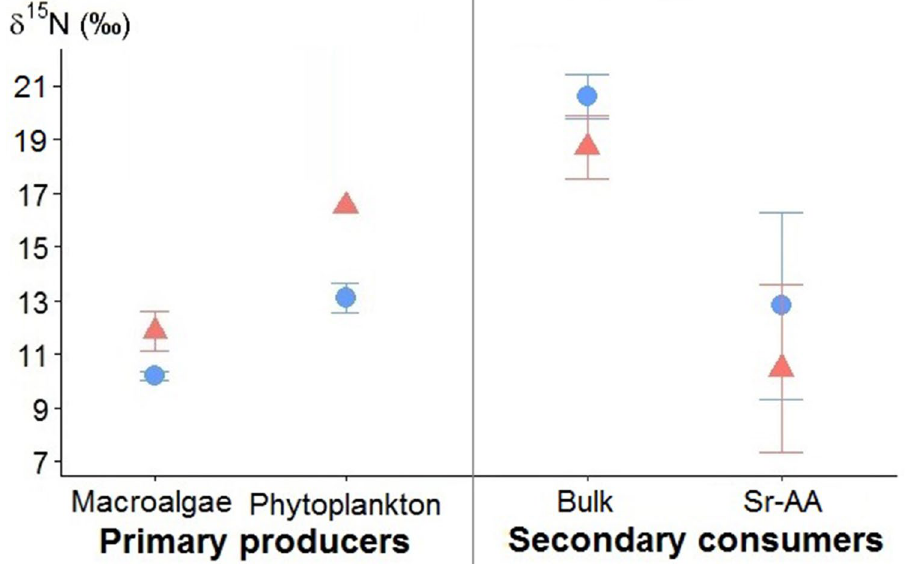
Figure 4. Seasonal variations of bulk δ 15 N values (means ± standard deviation) for the most integrated primary producers (left panel), and bulk, and Sr-AA (phenylalanine and glycine) for our eight targeted secondary consumers, all species pooled (right panel). Blue dots: winter, red triangles: summer.